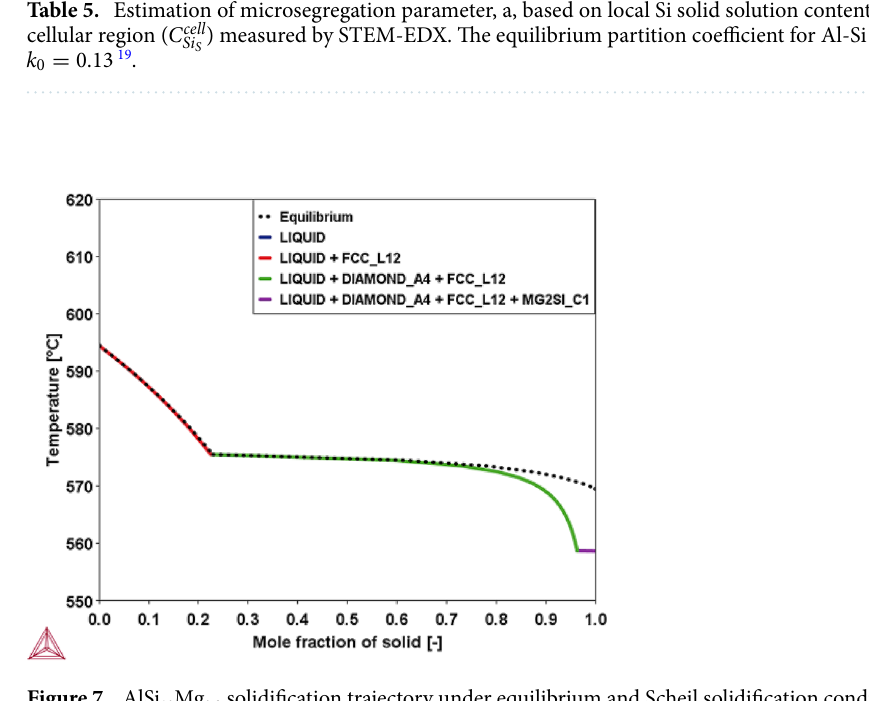
Figure 7. AlSi 10 Mg 0.3 solidification trajectory under equilibrium and Scheil solidification condition is simulated in Thermo-Calc. Phases included in the model are liquid, primary Al (FCC_L12), Si (DIAMOND_A4), Mg 2 Si